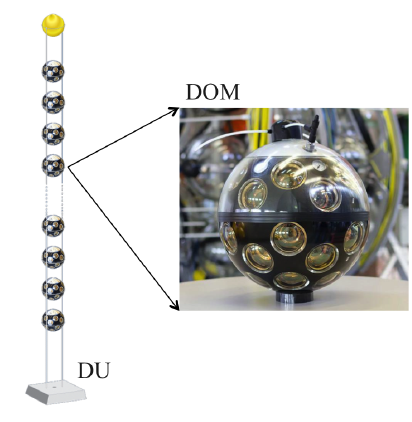
Figure 1. Schematic outline of a KM3NeT / ARCA building